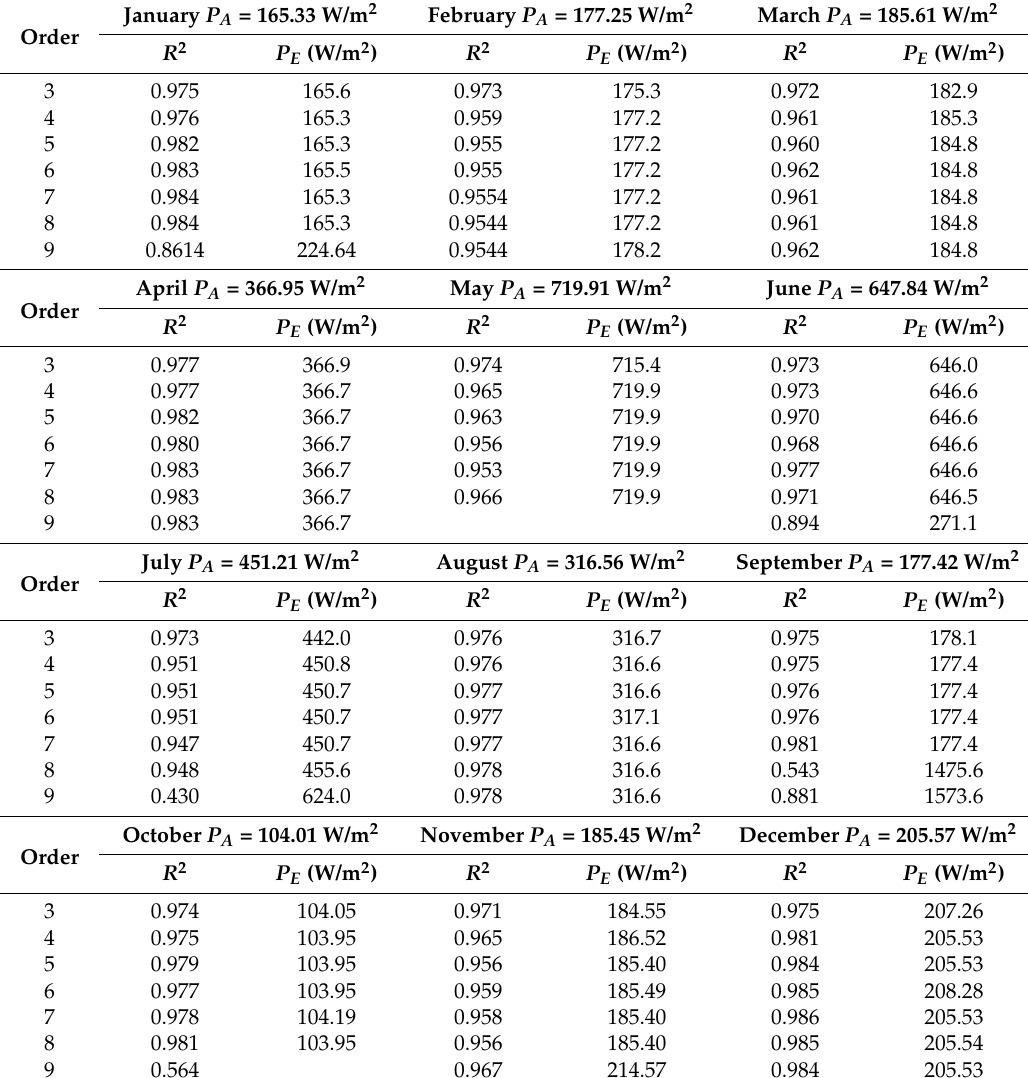
Table 4. Monthly comparison of actual wind power densities ( P A ) with Weibull power densities ( P W ) (Table 2) and power densities based on MEP-based function for orders 3–9 ( P E ).